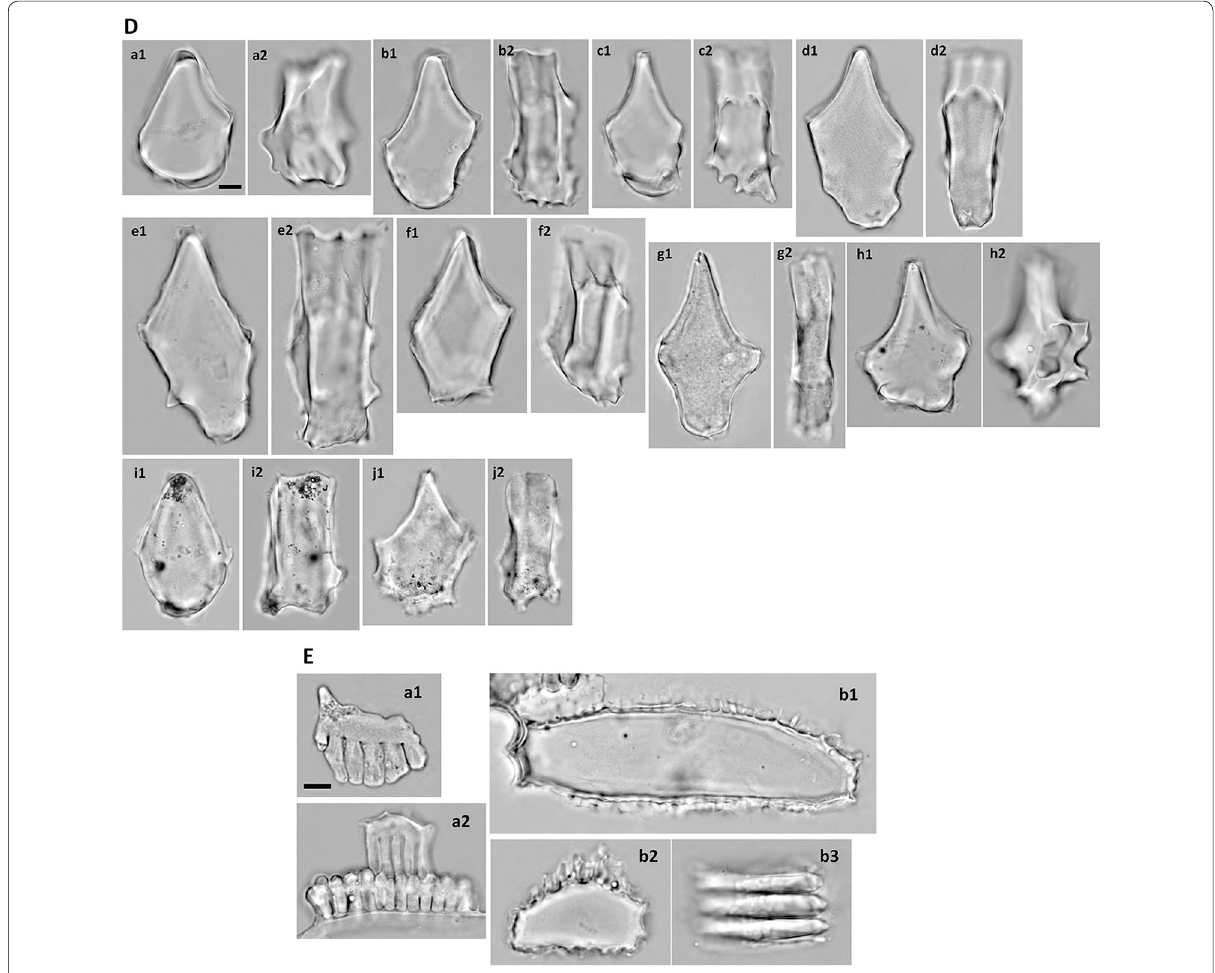
(Fig. 3). End profiles of bulliform phytoliths of Panicoideae, Pooideae, and Micrairoideae are relatively rectangular because of larger L2, larger L4 and smaller Circ_b (Fig. 3); noideae, and Chloridoideae are cuneiform with obvious circular bottoms (small L2, small L4, and large